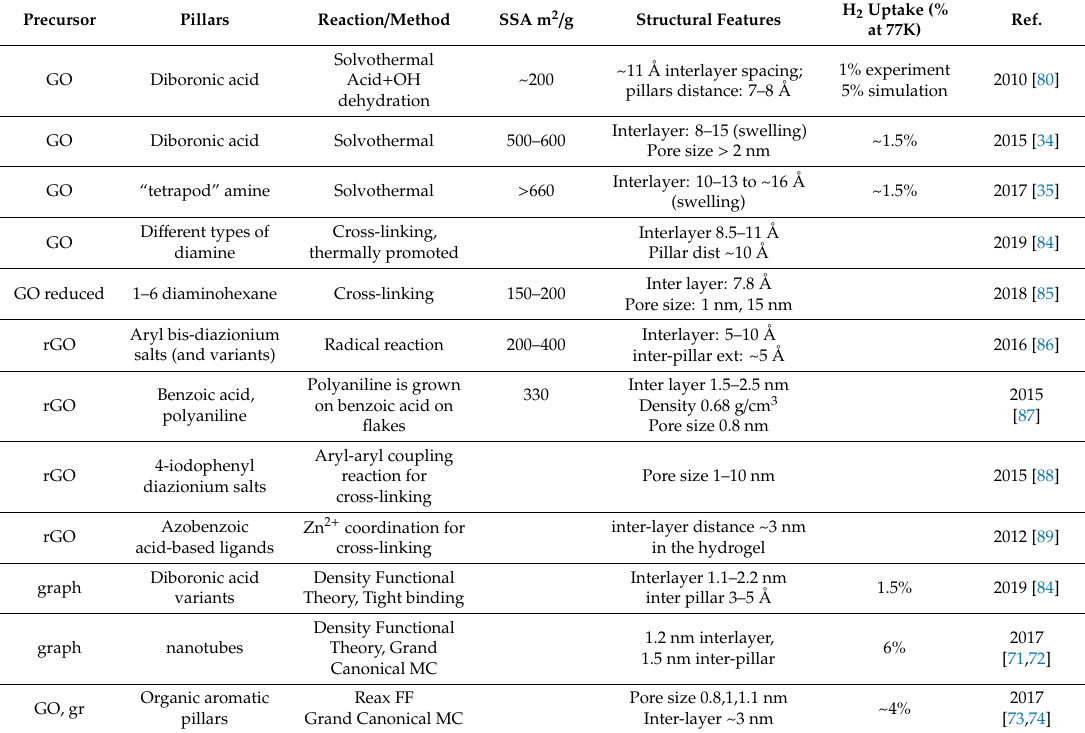
Table 2. Pillared materials derived by Graphite Oxide (GO) or reduced GO (rGO) flakes and their structural